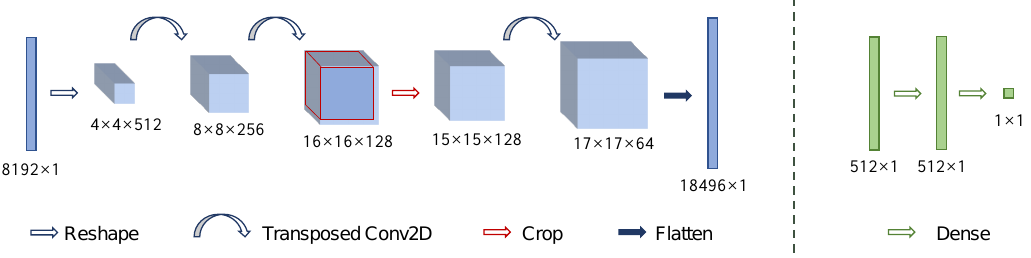
Figure 2. Feature map changes of the feature generator G ( left ) and the feature discriminator D ( right ). G starts by a dense layer to expand the input low dimensional (e.g., 100 × 1) noise to an appropriate size (8192 × 1) to be reshaped to a piece of small feature maps (4 × 4 × 512). 2D transposed convolutional layers (Transposed Conv2D) are applied to up-scaling feature maps. Among the procedure, we crop the 16 × 16 feature maps to 15 × 15 by abandoning the last row and the last column to make them up-sampled smoothly to match the target size (17 × 17 × 64). Flattening feature maps with the size yields the generated fake high-level features. D comprises simply of three dense layers and transforms the input real/fake high-level features into real value